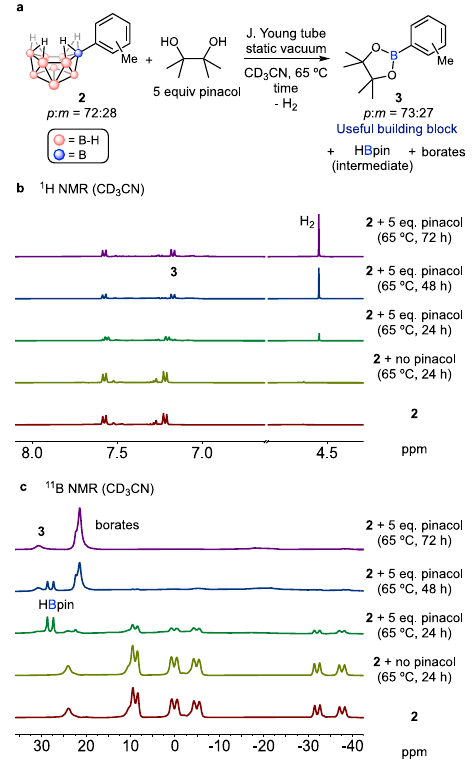
Fig.2|Monitoringofdeconstructionof2byNMRspectroscopy.a Formationof 3 , H 2 , HBpin and borates by the deconstruction of 2 in the presence of pinacol in CD 3 CN. b Stacked 1 H NMR spectra of the reaction mixture. c Stacked 11 B NMR spectra of the reaction